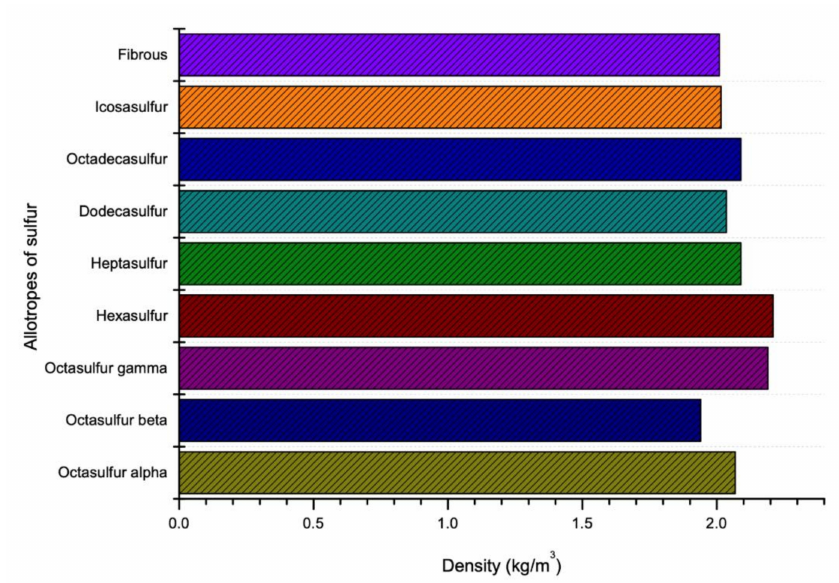
Figure 7. Density of sulfur in accordance with temperature and allotropes (data extracted from References